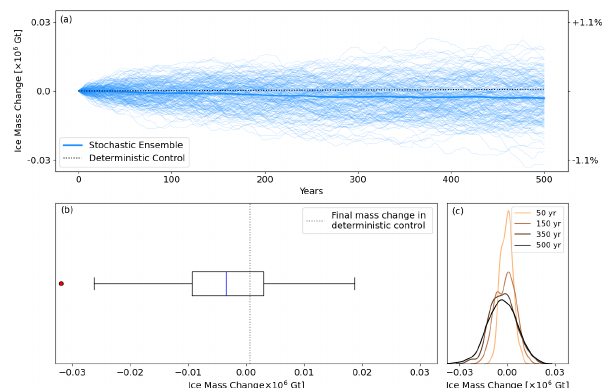
Figure 8. (a) Change in ice mass throughout the transient experi- ment for each ensemble member in the GrIS ensemble. The thick line shows the ensemble mean. The right y axis shows change rela- tive to the initial ice mass. (b) Boxplot of the final ice mass distribu- tion. Red dots indicate ice masses beyond 1.5 times the interquartile range from the quartile. (c) PDF of the ice mass change after 50, 150, 300, and 500 years of simulations.